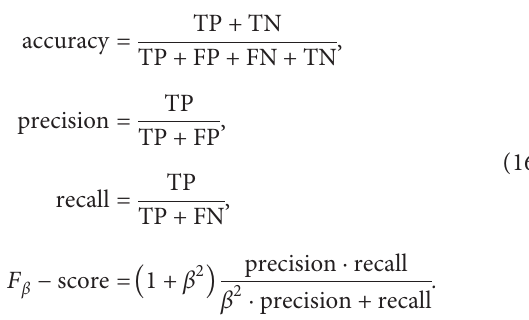
Table 2: Grey correlation degree between each comparison se- quence and reference